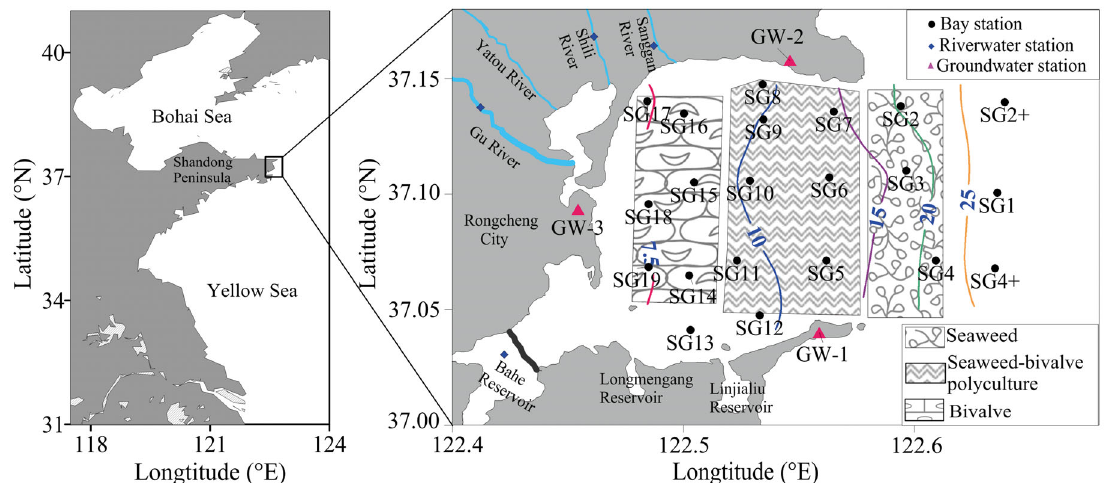
Fig. 1. Locations of field sampling and observation sites in Sanggou Bay in April, July and October